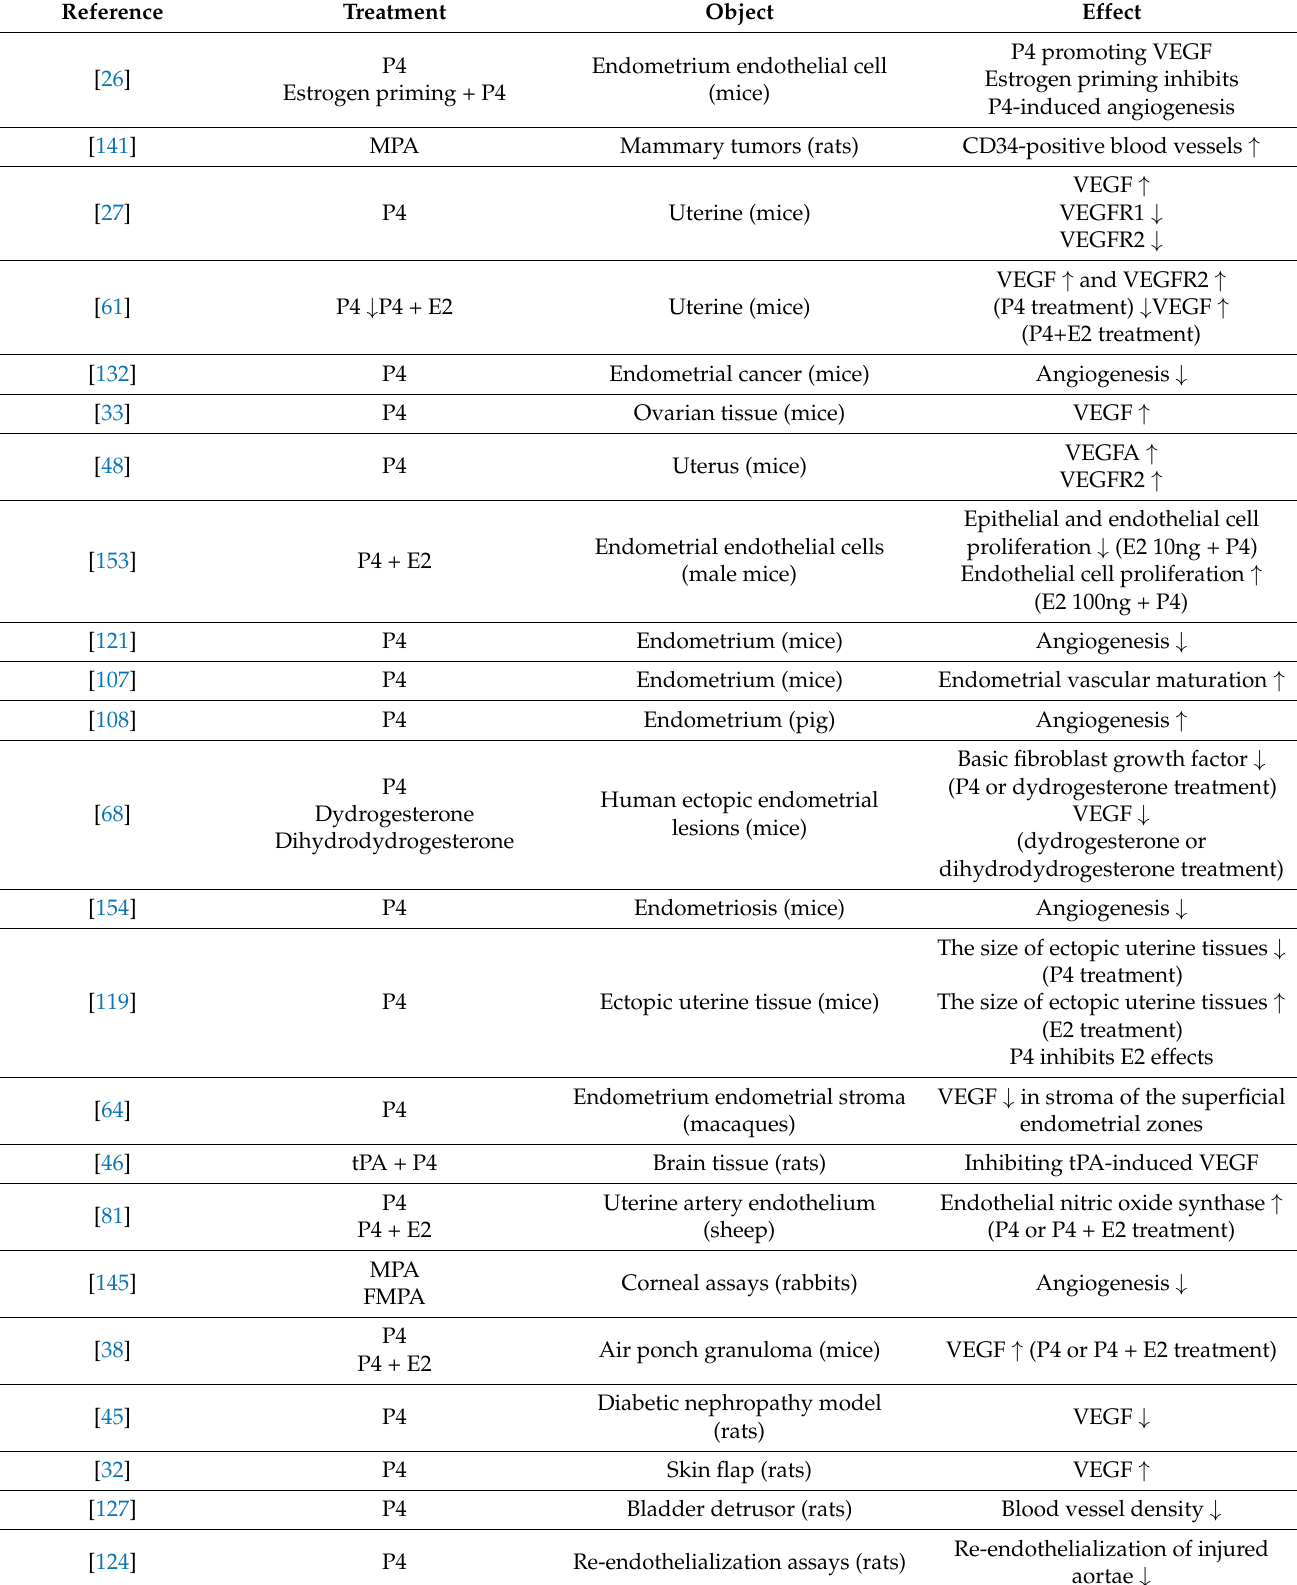
Table 2. The influence of progestogens in in vivo studies: ↑ indicates a promoting effect; ↓ indicates an inhibitory effect. FMPA: 9alpha-fluoromedoroxyprogesterone